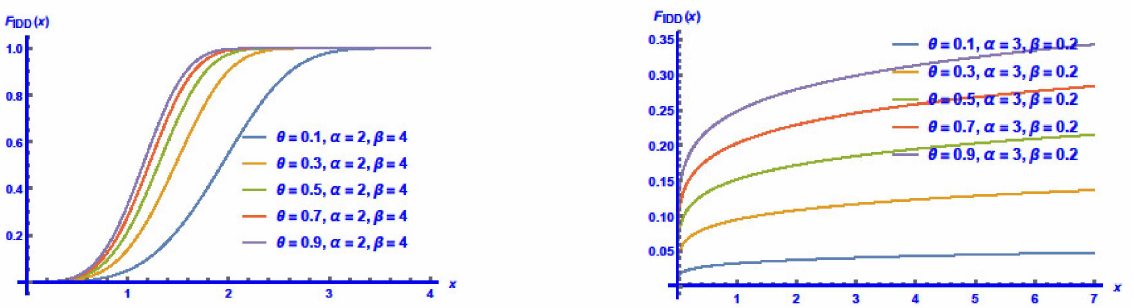
Figure 1. Plots of the CDF of PDD for varying the value of α , β , θ .